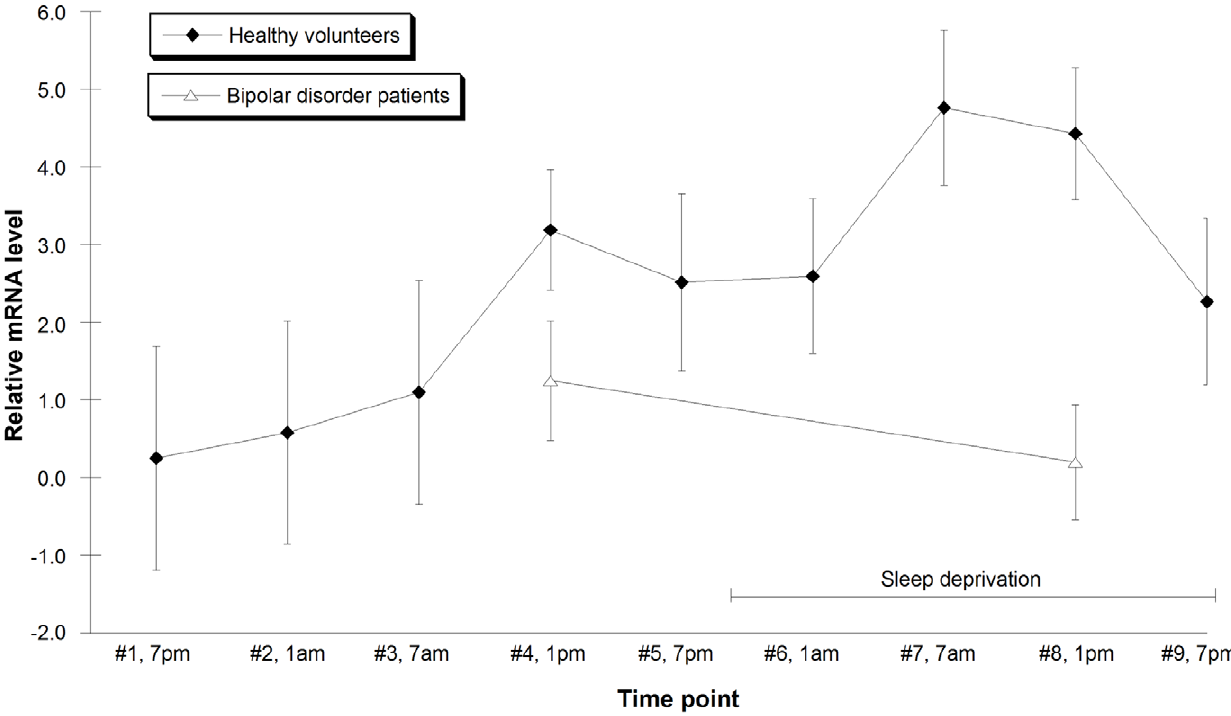
Figure 1. CRY2 gene expression in healthy volunteers and bipolar disorder patients. CRY2 mRNA expression was not changed by sleep deprivation in bipolar disorder patients (triangle) and was significantly decreased compared to healthy volunteers (square) during sleep deprivation. Blood draw 1 (x-axis) was at 7 p.m., then there was a blood draw every 6 hours. Sleep deprivation was at time points # 6, # 7, # 8 and # 9. Bars indicate mean and error bars indicate SEM.